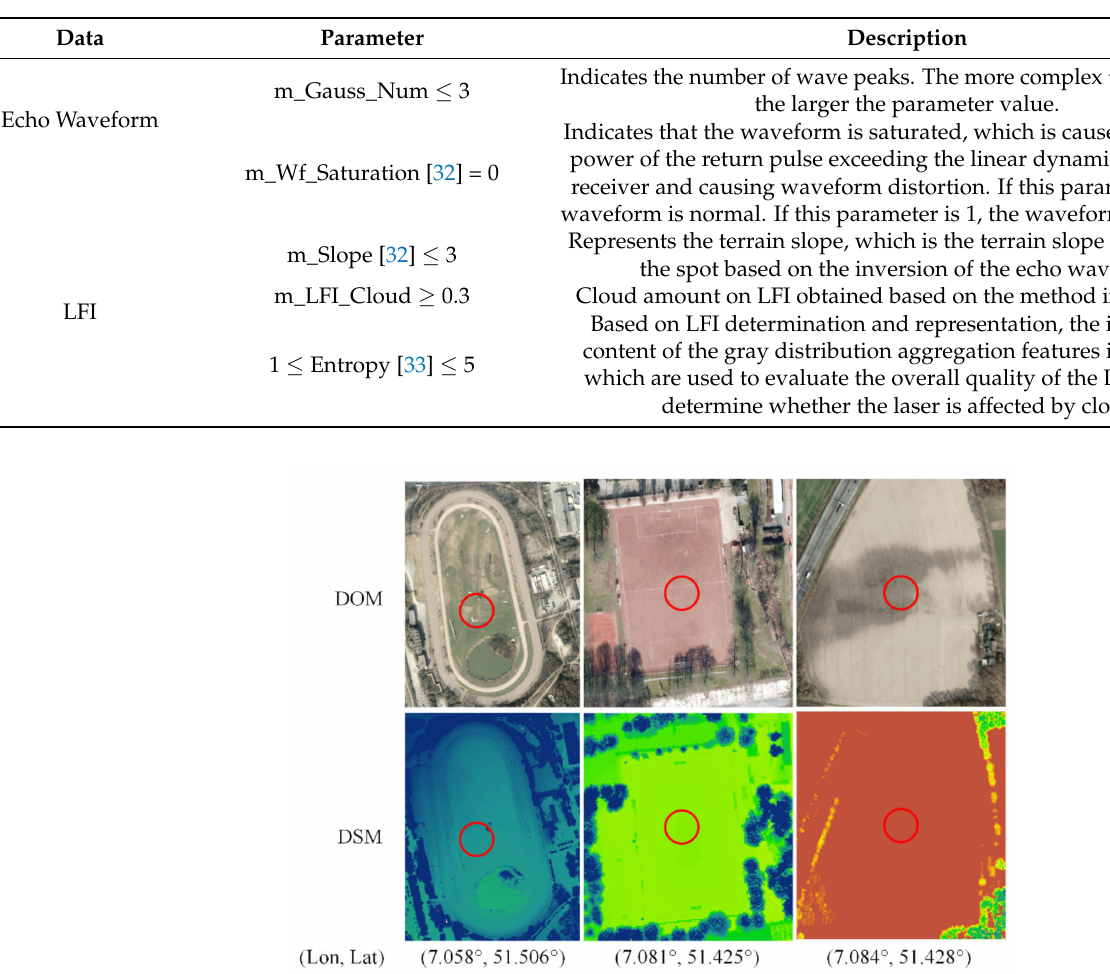
Table 5. Screening indicators for land area data.